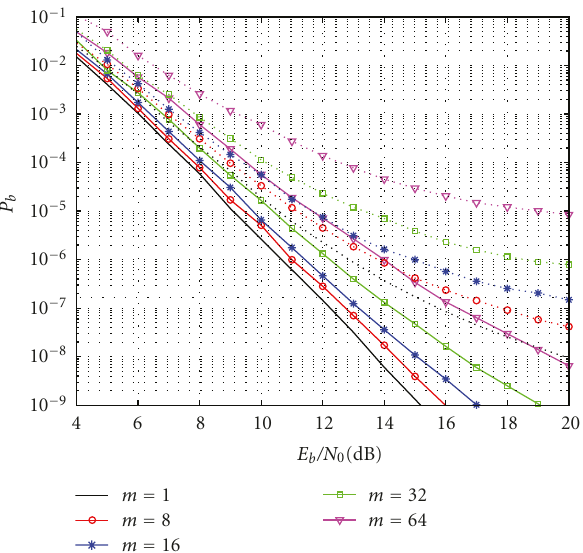
Figure 2: Performance of a rate-1 / 2 convolutionally coded FHSS system with perfect CSI for 10 users ( K = 10) and di ff erent hop lengths m = 1,8,16,32,64 (solid: approximation using the union bound, dash: simulation).